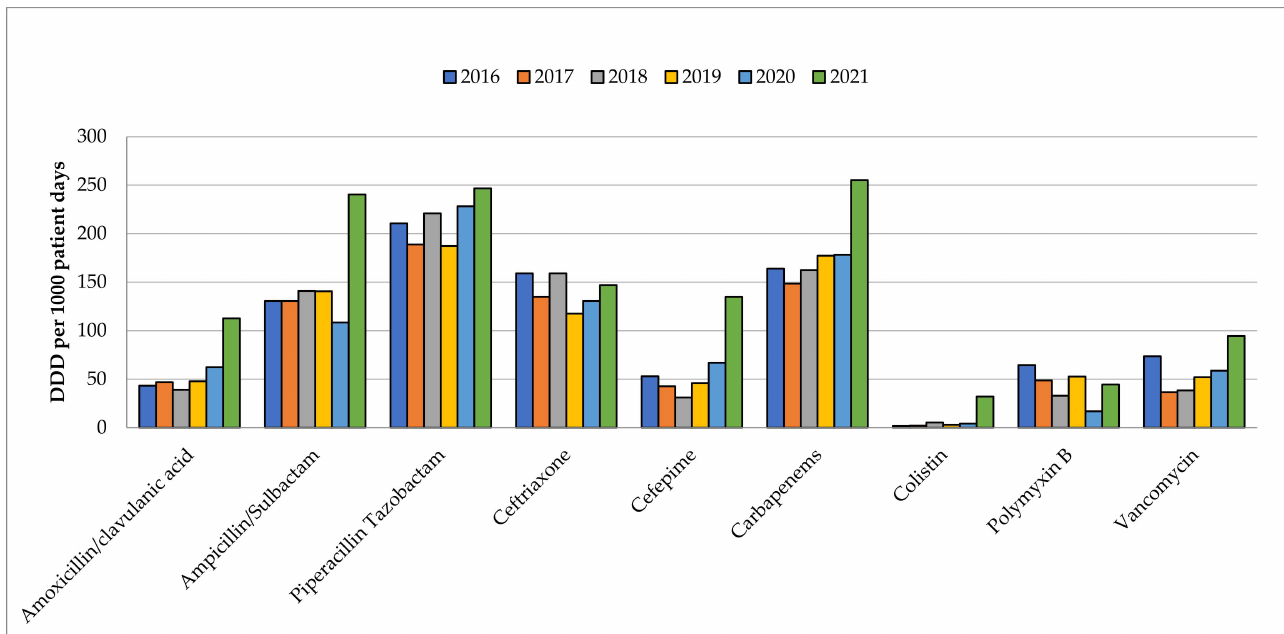
Figure 1. Annual Antibiotic Utilization in COVID-19 ICU and GICU from the year 2016 to the year 2021.